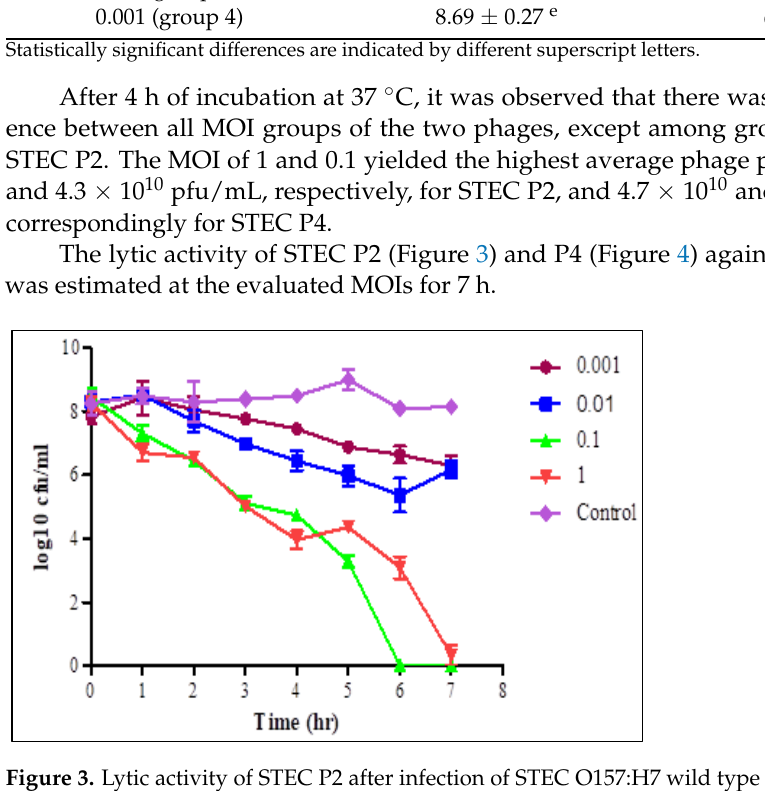
Figure 4. Lytic activity of STEC P4 after infection of STEC O157:H7 wild type strain 93111 at MOI of 1, 0.1, 0.01 and 0.001 for 7 h. LSD value at 0.05: 0.523. At each time interval, decreasing the count of STEC cells in infected cultures, with different MOIs, was observed comparing with the phage—free bacterial culture. After one hour, there was a significant decrease in the STEC cells count in phage infected cultures with MOIs of 0.1 and 1 pfu/cfu, and a sharp decrease was observed with MOI of 1. With MOI of 1, the average counts reduced from 8.27–6.7 and from 7.2–4.26 log cfu/mL in the cultures infected with STEC P2 and P4, respectively. The selected phages displayed a com- plete lysis efficiency of bacteria after 6 h of infection with STEC P2 and P4 with MOI of 0.1 and 1, respectively. STEC P4 with MOI of 0.1 also had the ability to lyse bacterial cells comprehensively after 7 h. Conversely, at the same tested time, the average count of E. coli cells reduced by 96.01% in the presence of STEC P2 with MOI of 1. 3.6. Effect of UV Radiation on Phage Stability The effect of UV radiation was evaluated by exposing STEC P2 and P4 virions to UV light (254 nm) for 75 min (Table 3). The results confirmed that the phage survival is in- versely proportional with exposure time to UV. For individual phages, there were no sig- nificant differences in virions count after exposure to UV radiation for 60–75 min. Con- versely, comparing plaque counts of the two irradiated phages revealed that there was a significant difference in the count of surviving virions after 60 and 75 min exposure to UV. The results suggested that the STEC P4 was more resistant to UV light as the highest re- duction percentage of virions count was estimated for STEC P2. After 75 min, 89.11 and 71.51% of the treated STEC P2 and P4, respectively, were inactivated.